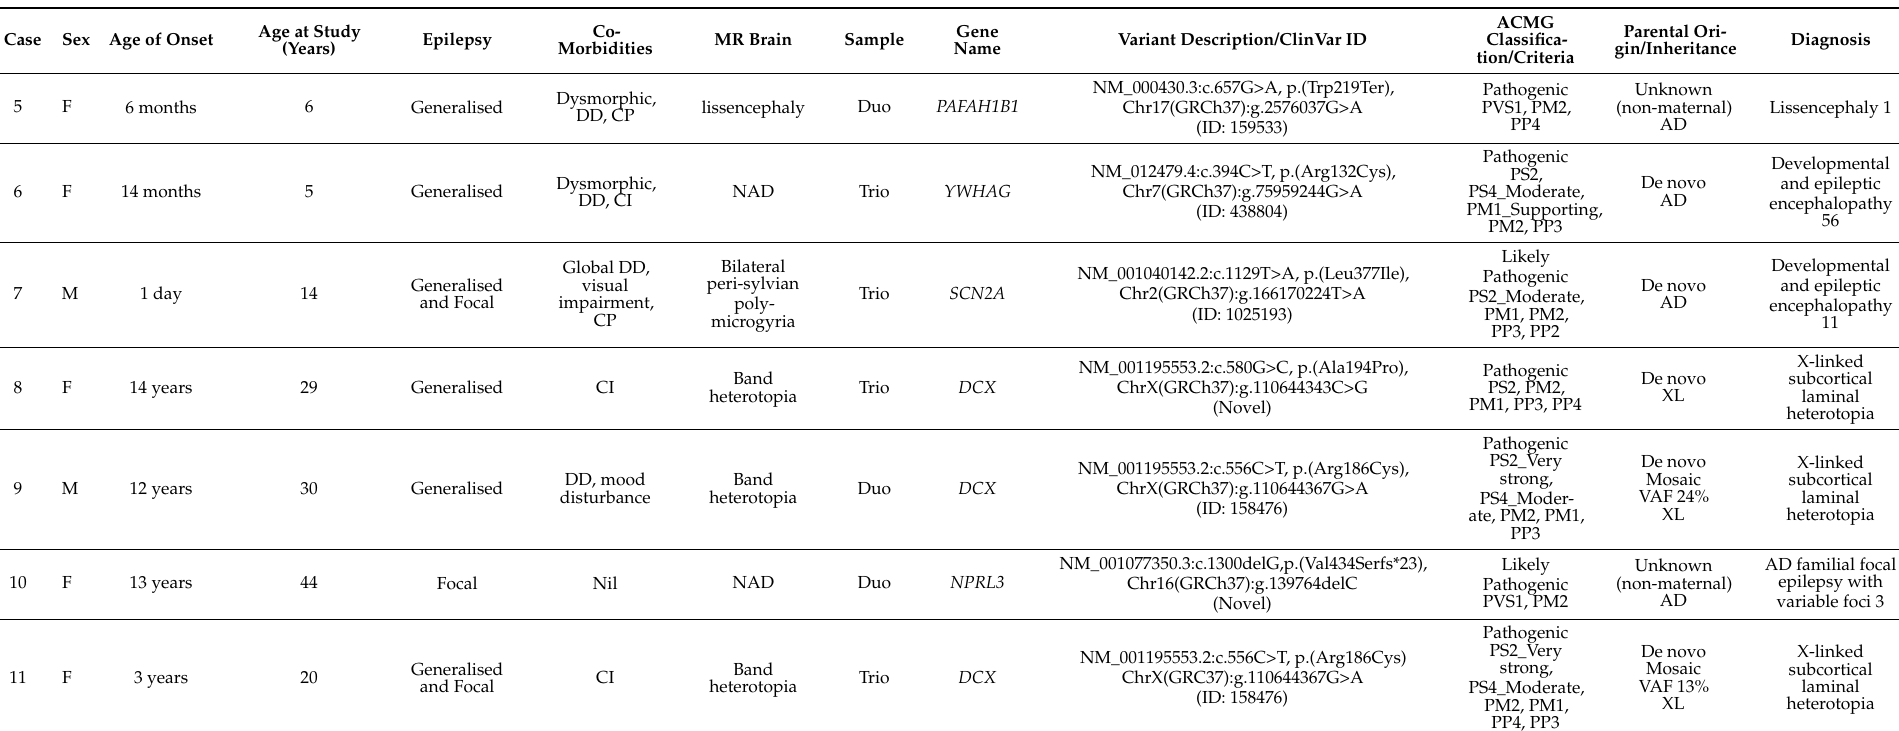
Table 2. Description of the seven cases where the genomic diagnosis was obtained using whole exome